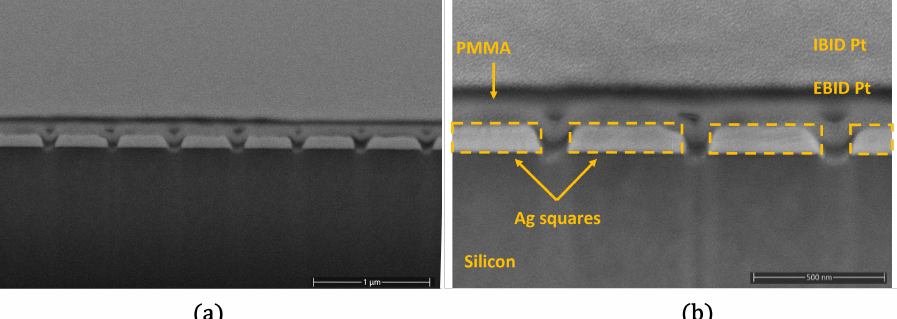
Figure 7. ( a ) Cross-section SEM image of the FIB patterned 1D silver grating covered by 50nm of electron beam induced Pt deposition (EBID), and 1µm of ion beam induced Pt deposition (IBID). ( b ) Zoom-in of the cross-section SEM image of the FIB patterned 1D silver grating with labels indicating precisely the different objects in the cross-section.